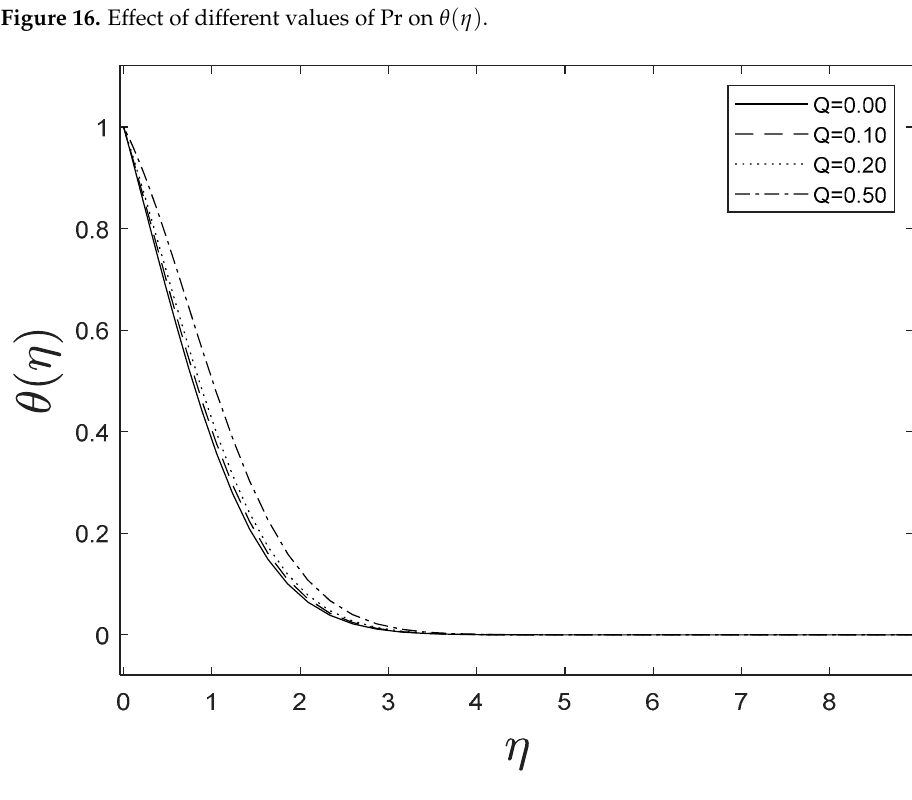
Figure 17. Effect of different values of Q on θ ( η )